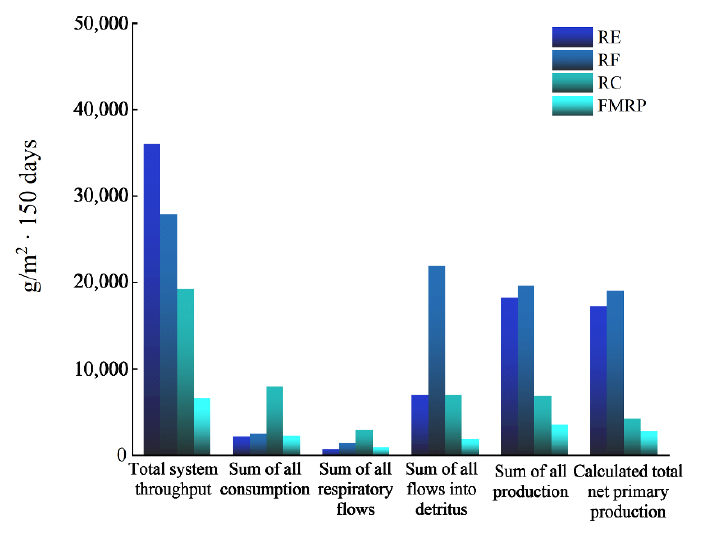
Figure 6. Comparison of energy flow parameters. RE: Rice–crab integrated multi-trophic aquaculture system; RF: Rice–carp integrated multi-trophic aquaculture sysytem; RC: Rice–crayfish integrated multi-trophic aquaculture system; FMRP: Pelteobagrus fulvidraco -integrated multi-trophic aquaculture system.